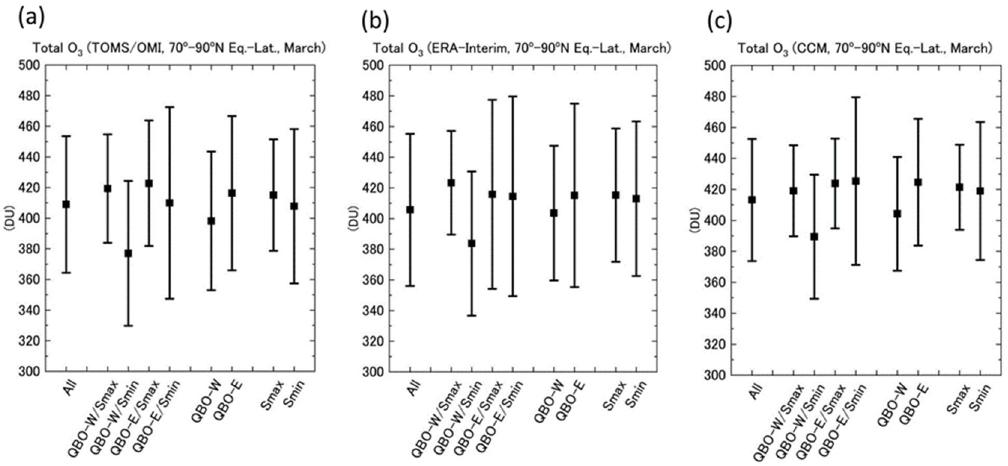
Figure 3. Monthly mean total ozone averaged over 70 − 90 N equivalent latitudes in March with units of dobson. The average values for all the years 1980–2011, the four QBO/solar activity phase groups, the two QBO phase groups, and the two solar activity phase groups are indicated by squares with the standard deviations. ( a ) TOMS/OMI data, ( b ) ERA-Interim data, and ( c ) CCM output.